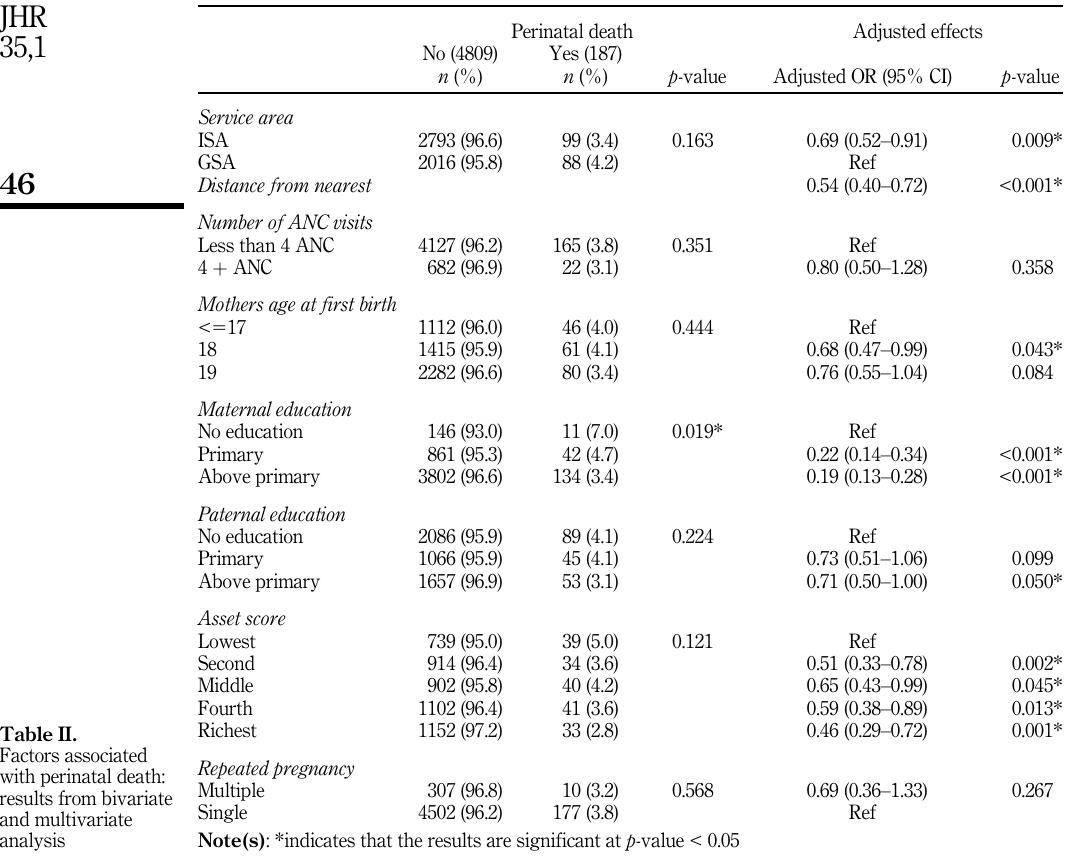
Table II. Factors associated with perinatal death: results from bivariate and multivariate